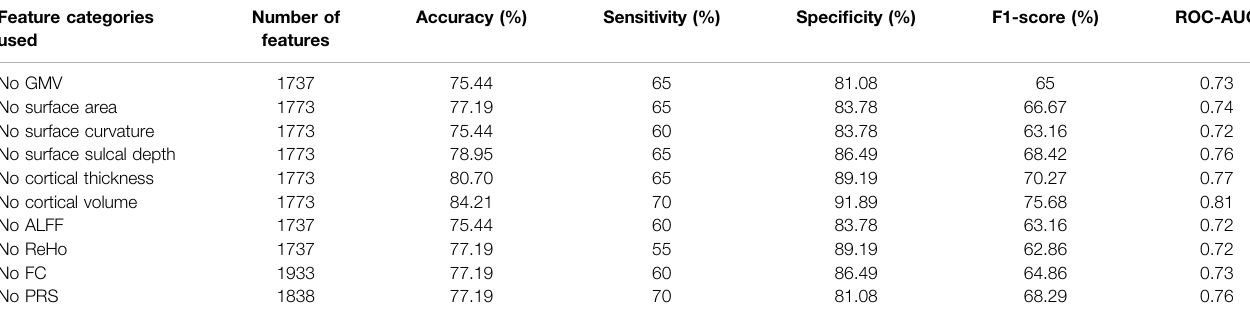
TABLE 5 | Prediction performance of classi fi ers trained with features after removing certain categories. Feature categories